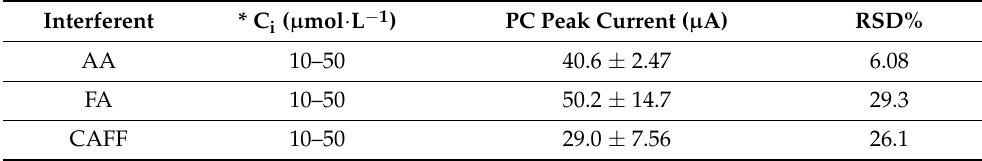
Figure 7. DPV results showing electrooxidation of 10 µmol·L −1 PC in 0.1 mol·L −1 phosphate buffer solution (pH = 7.03) at ERGO-SbNPs-PGE in the presence of interferents: ( A ) AA, FA ( B ), and CAFF ( C ) at different concentrations. Table 2. The results below show the effect of interferences, namely, AA, FA, and CAFF, on the oxi- dation peak current of PC at different concentrations and their RSD%.